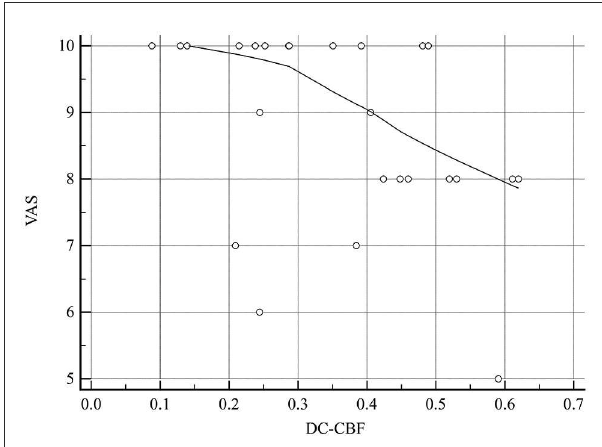
FIGURE11 There was a significant negative correlation between DC–CBF of the brain regions with altered NVC and VAS score in patients with